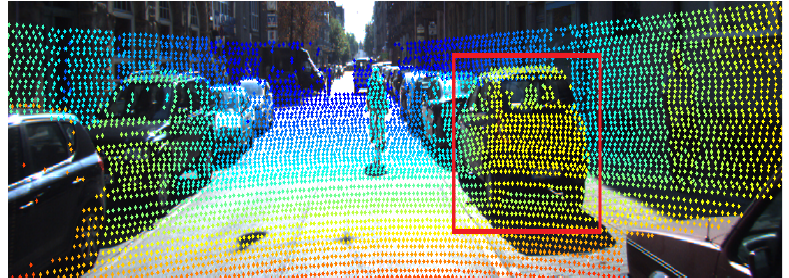
Figure 8. Result on hypothesis verification